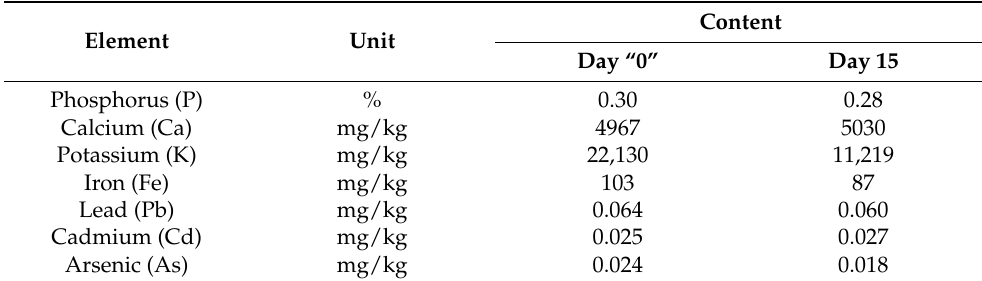
Table 3. Minerals and heavy metals detected in grape pomace before (day “0”) and after 15 days of SSF by R. oryzae in tray